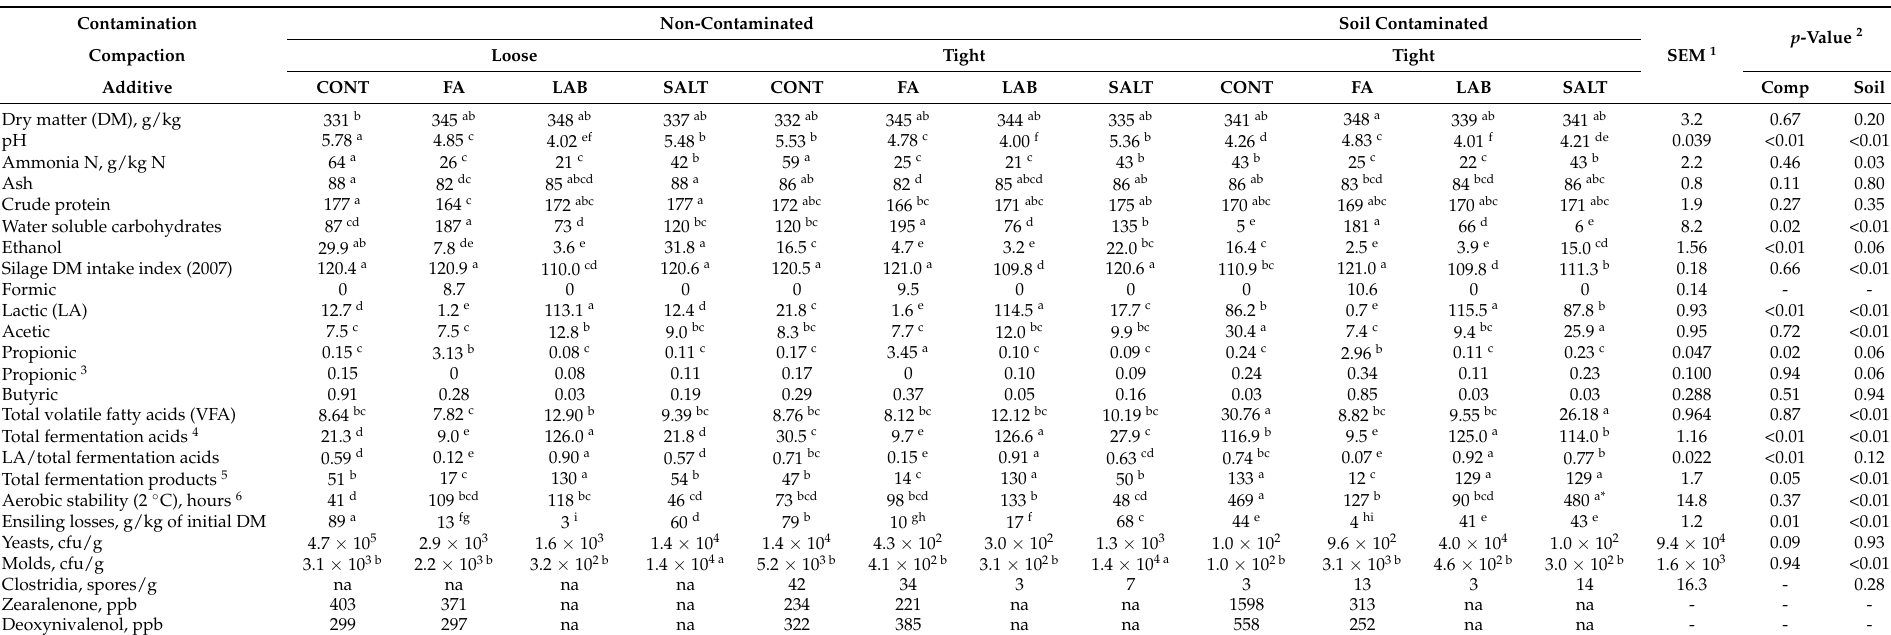
Table 2. Fermentation quality, chemical composition, aerobic stability, ensiling losses and microbial composition of grass silages treated with different additives under two compaction (Comp) and soil contamination (Soil) levels.